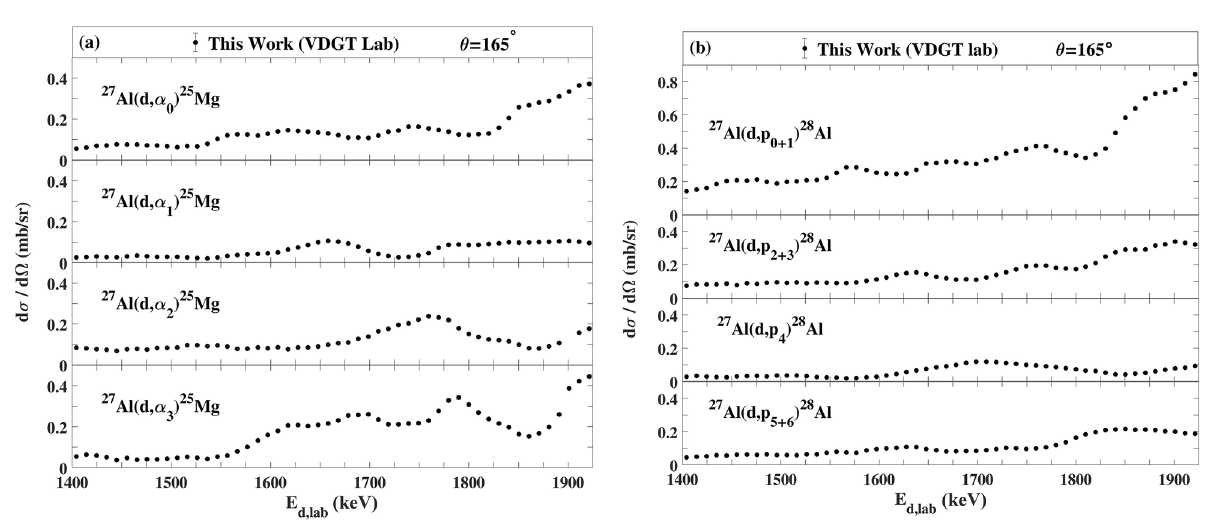
Figure 6. The differential cross sections at 165° measured at VDGT Lab in Tehran for the ( a ) 27 Al(d,α) 25 Mg and ( b ) 27 Al(d,p) 28 Al reactions. The estimated uncertainties from counting statistics are smaller than the plotted